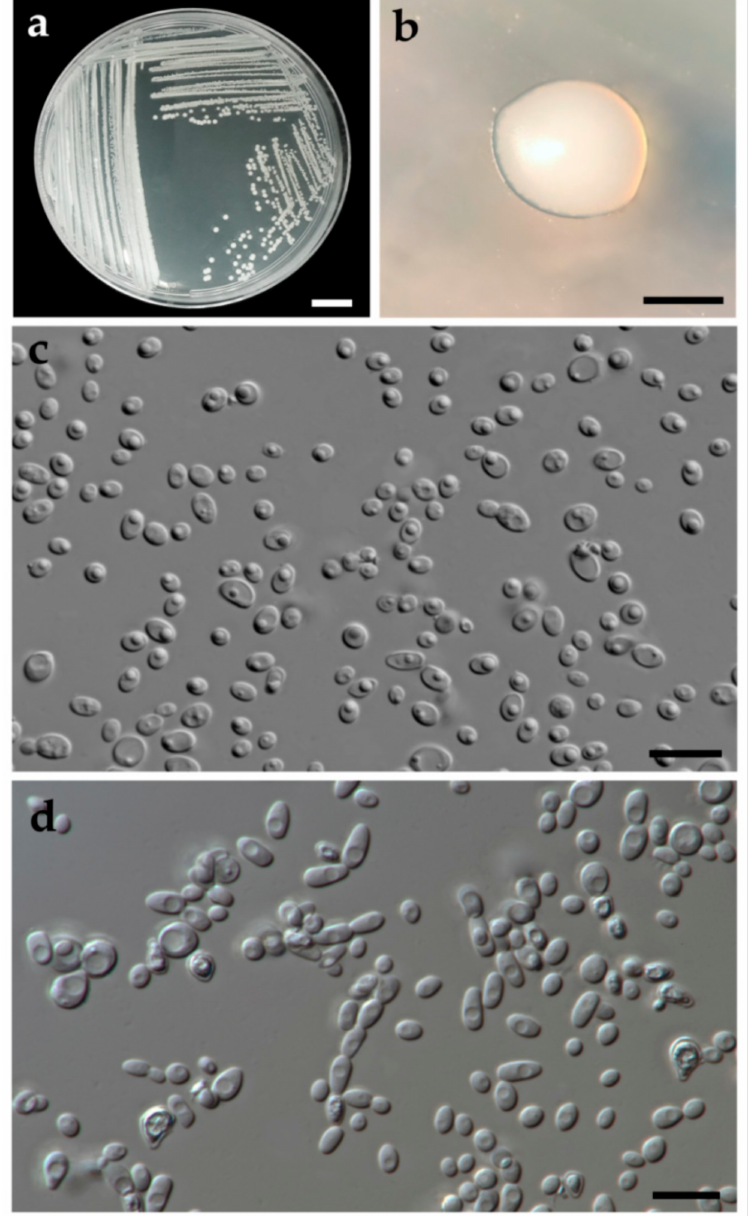
Figure 5. Wickerhamomyces nanensis (holotype SDBR-CMU-S3-15). Culture ( a ), single colony ( b ) and budding cells ( c ) on YMA after two days at 30 ◦ C. Pseudohypahae ( d ) on 5% MAE agar after 7 days at 25 ◦ C. Scale bar a and b = 10 cm, c and d = 10 µ